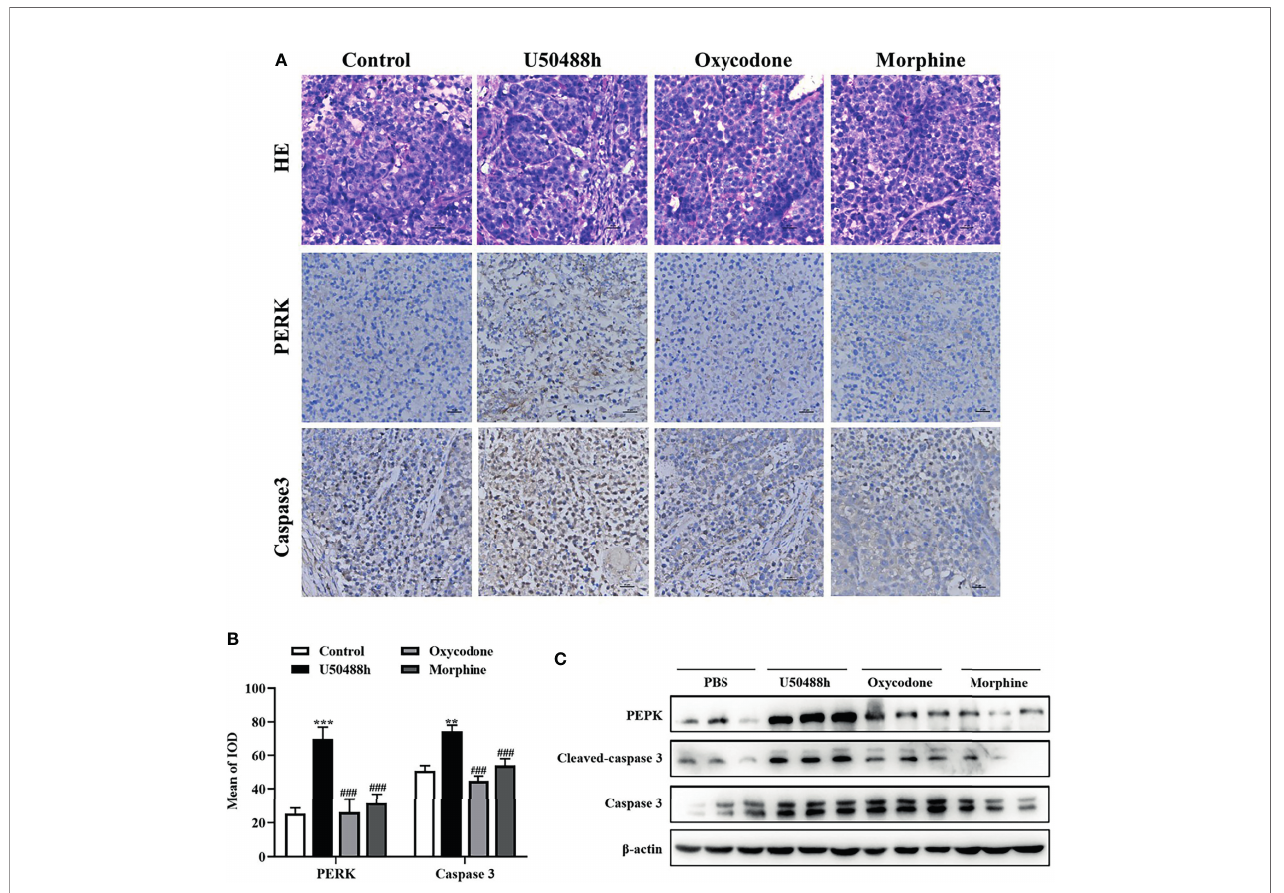
FIGURE 7 | KOR agonist increased expression level of PERK and Caspase 3 in vivo . (A) Representative IHC staining in tumor tissue for PERK and Caspase 3 in the control and OR agonists treated mice (n=5) (scaled bar= 25 um); (B) Histogram represent the mean of IOD. (C) Levels of PERK and Caspase 3 determined by western blot (n = 3). Data are presented as mean±SEM. **P < 0.01, ***P < 0.001 vs. control group; ### P < 0.001 vs. U50488h